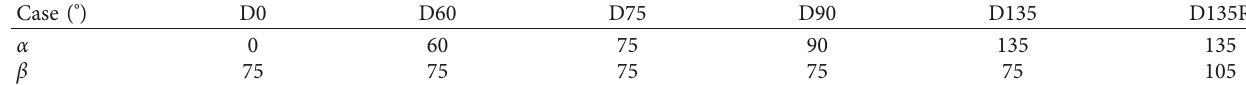
Table 1: Designed experiments with employing different dip angles for the two